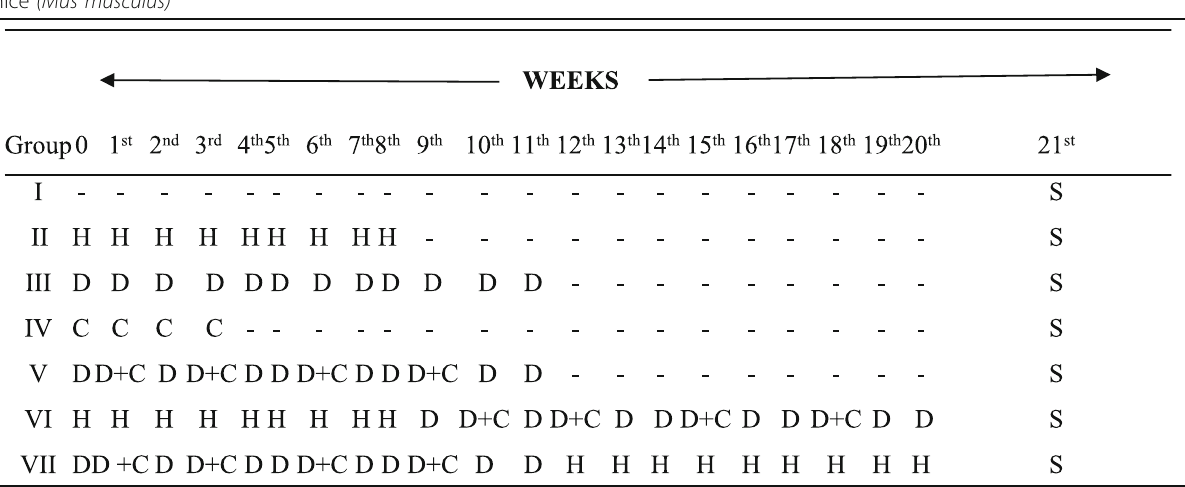
Table 1 Different doses of carcinogen (DEN/CCl 4 /DEN+CCl 4 ) and harmalol during 0 – 21 weeks of treatment in male Swiss albino mice (Mus